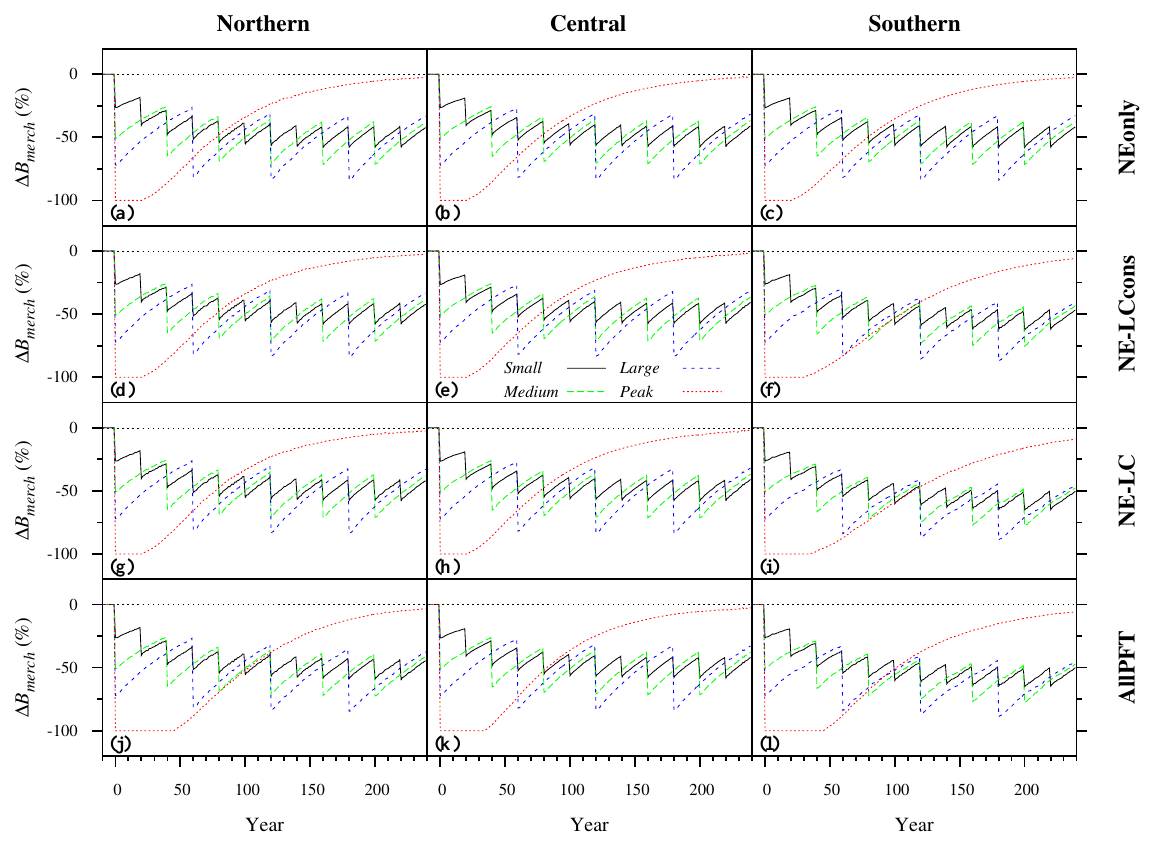
Figure 2. Transient effect of the different MPB outbreak regimes on lodgepole pine merchantable biomass ( B merch ) compared with the no-outbreak control run (first outbreak occurred in year 1). The columns correspond to the three locations (Fig. 1) and the rows to the four vegetation coexistence scenarios (Table 2). Control values differed among locations and vegetation coexistence scenarios, so the same relative change (in %) across the 12 panels does not correspond to the same absolute